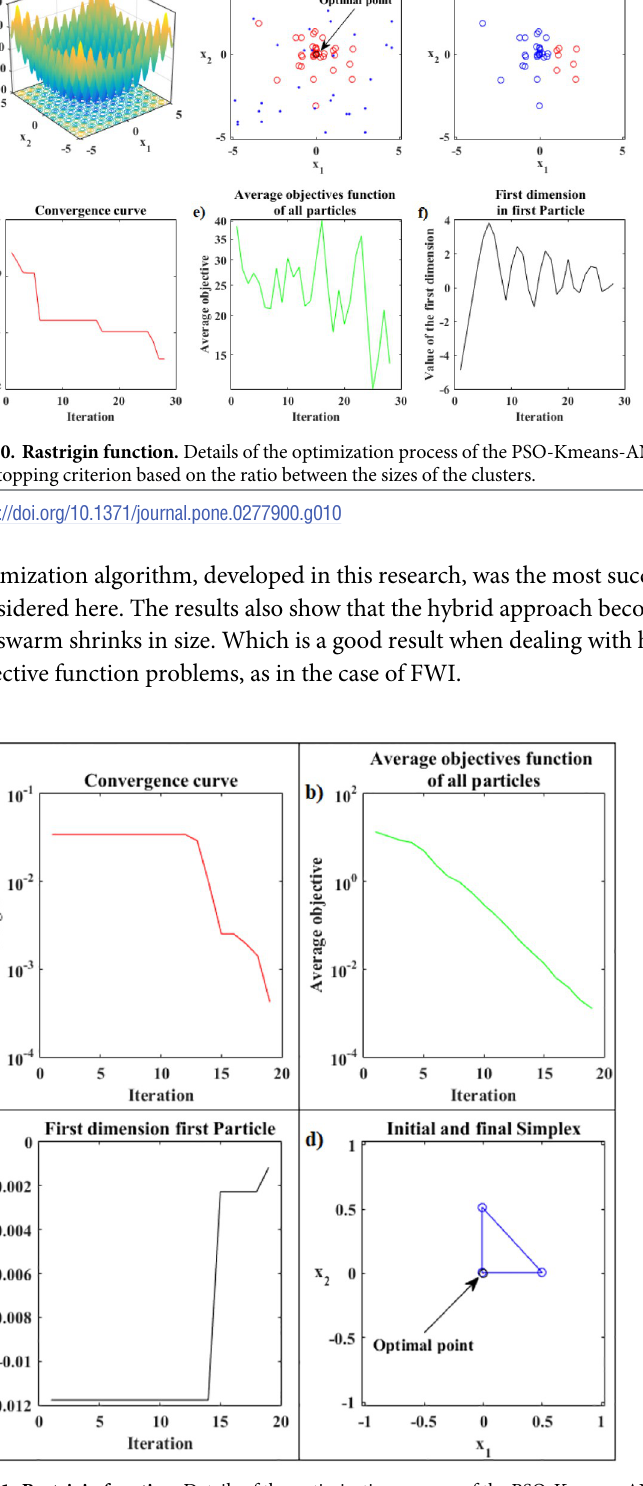
Fig 11. Rastrigin function. Details of the optimization process of the PSO-Kmeans-ANMS algorithm in Phase 2.